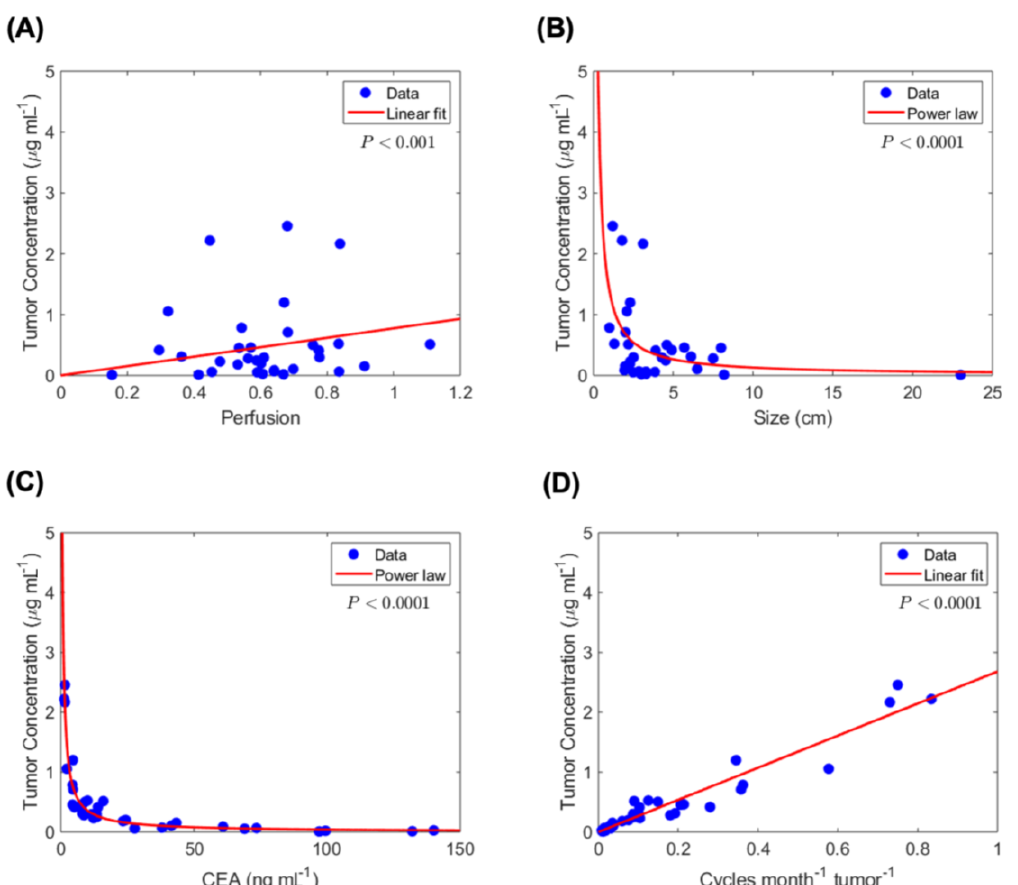
Figure 3. Estimated tumor-site chemotherapy concentration correlation with diffusion-and clinical-based variables. Sta- tistically significant correlations are observed between tumor-site chemotherapy concentration and ( A ) tumor perfusion, ( B ) tumor size, ( C ) serum CEA level, and ( D ) chemotherapy dose overtime per unit tumor burden.